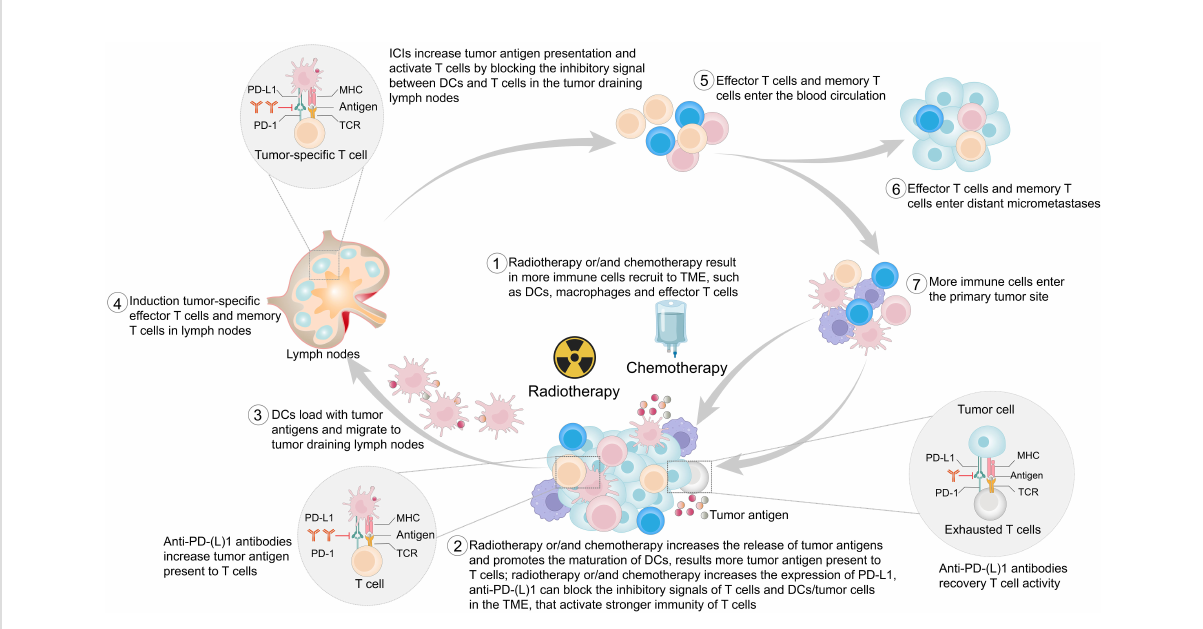
FIGURE 2 This fi gure provides a stepwise overview of the potential mechanism of the synergistic antitumor effect of immune checkpoint inhibitors (ICIs) combined with radiotherapy and/or chemotherapy. PD-1, programmed cell death protein 1; PD-L1, programmed cell death 1 ligand 1; MHC, major histocompatibility complex; TCR, T-cell receptor; TME, tumor microenvironment; DCs, dendritic